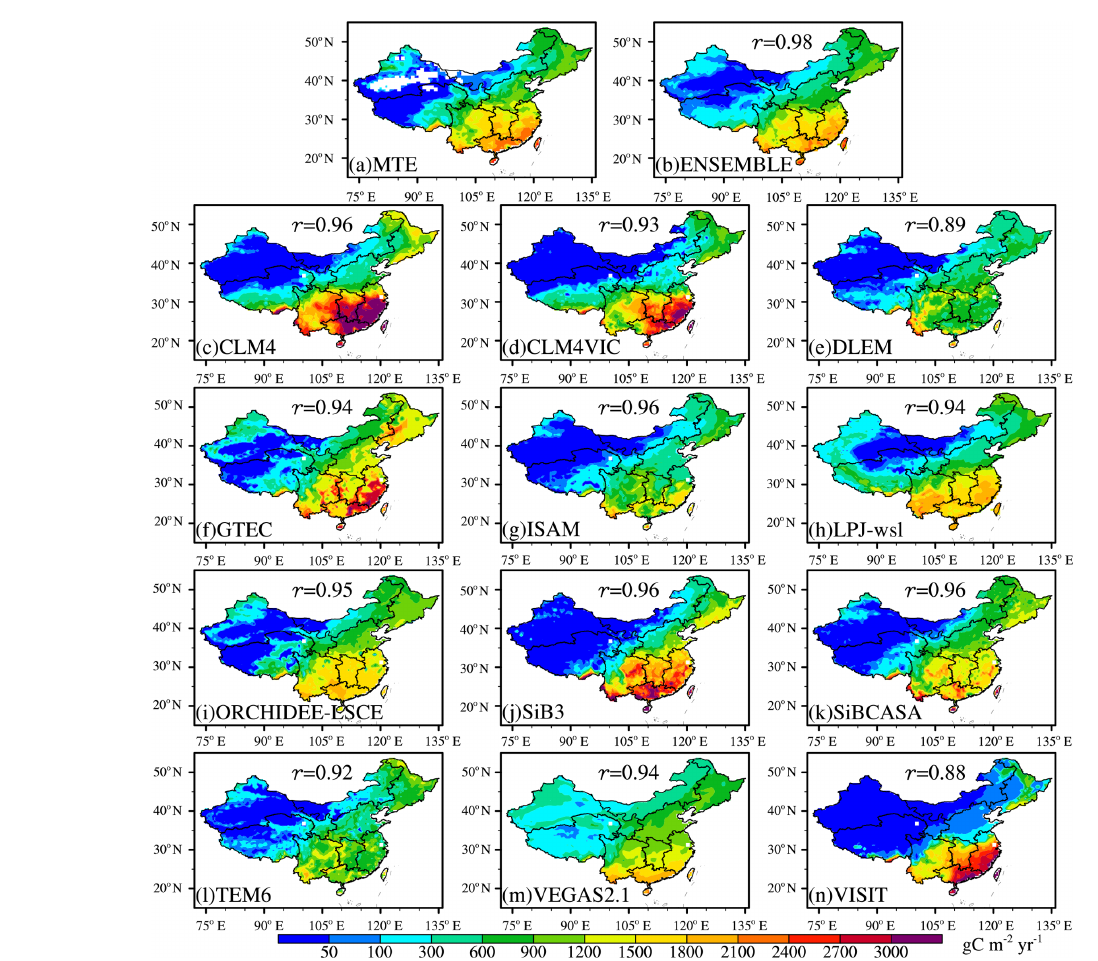
Figure 2. Average annual terrestrial ecosystem gross primary production (GPP) from the MTE (1982–2010) and MsTMIP (1981–2010). r is the spatial correlation coefficient with the MTE, and ENSEMBLE is the ensemble mean of the 12 MsTMIP models.